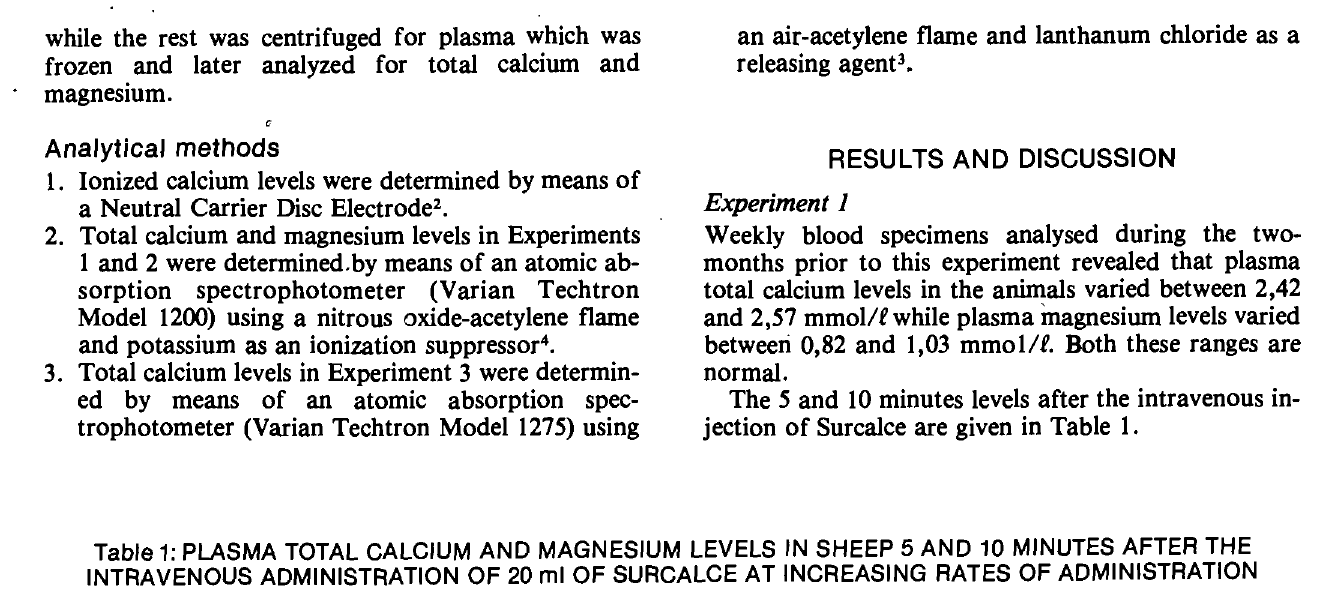
Table 1: PLASMA TOTAL CALCIUM AND MAGNESIUM LEVELS IN SHEEP 5 AND 10 MINUTES AFTER THE INTRAVENOUS ADMINISTRATION OF 20 ml OF SURCALCE AT INCREASING RATES OF ADMINISTRATION Rate of Plasma calcium mmol/t